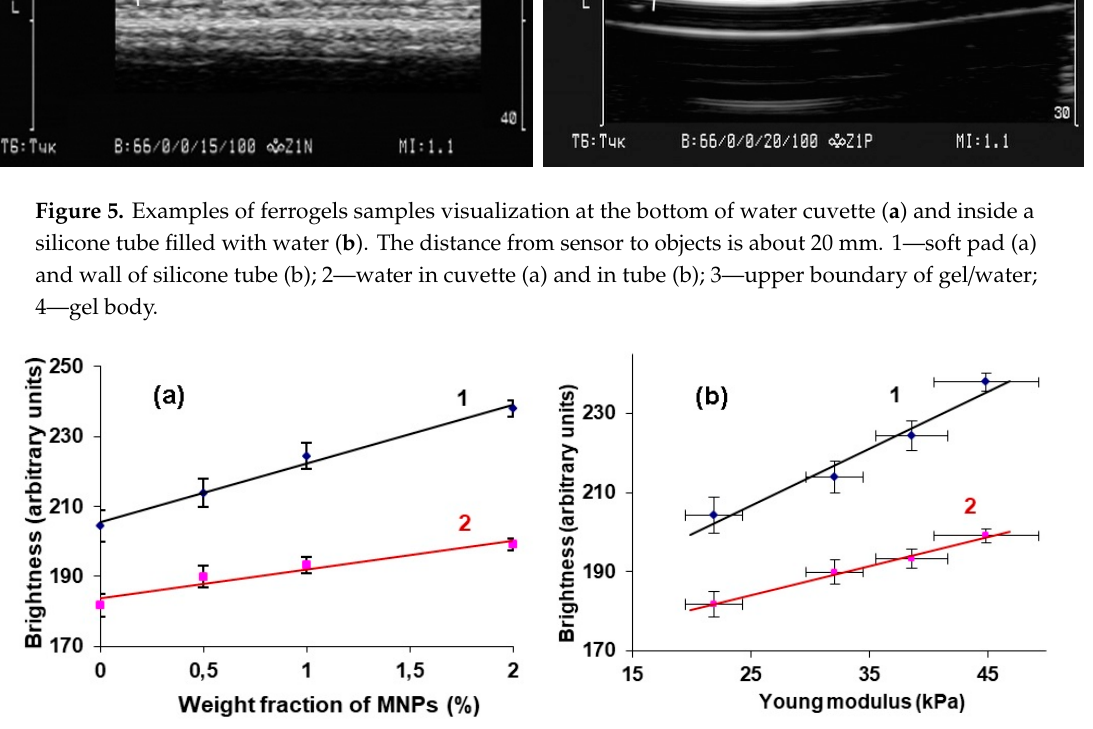
Figure 6. Dependences of maximal (1) and average brightness (2) at gel / water boundary on the MNPs concentration for samples of batch #1 ( a ). Vertical bars reflect the confidence interval with p = 0.05. Dependences of maximum (1) and average brightness (2) at gel / water boundary on Young’s modulus for samples of batch #1 ( b ). Vertical and horizontal bars reflect the confidence interval of relevant parameter with p = 0.05.